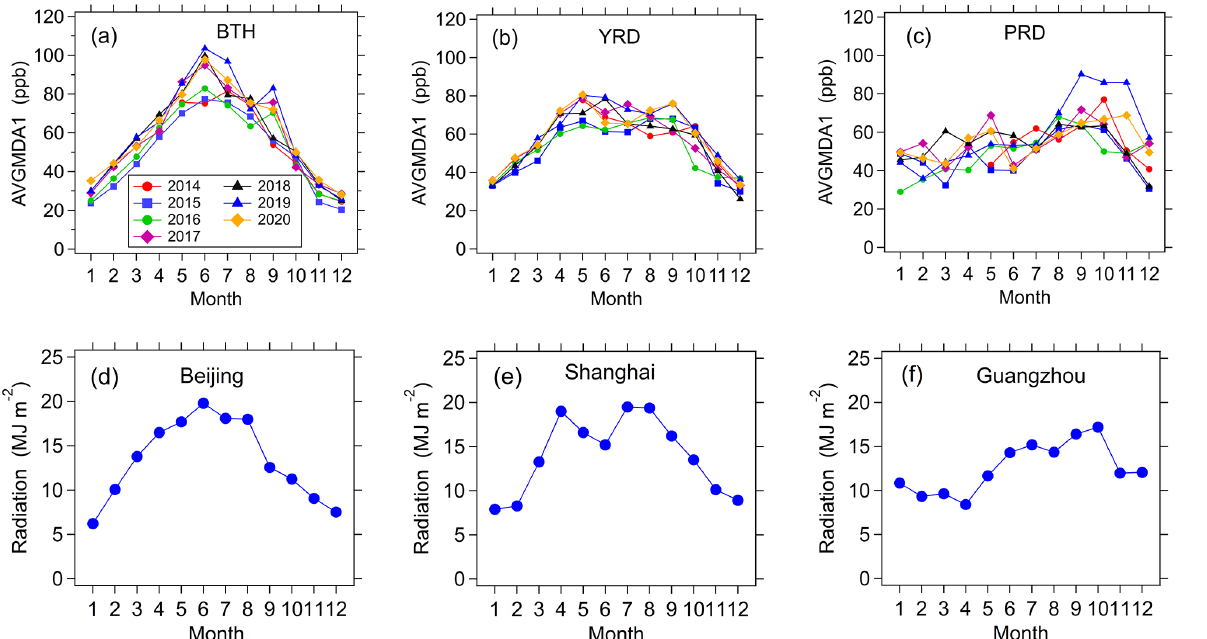
Figure 3. Seasonal variations in monthly mean MDA1 O 3 concentrations over all sites in BTH (a) , YRD (b) and PRD (c) during 2014– 2020. Seasonal variations in monthly mean solar radiation in representative cities of the three city clusters: Beijing in BTH (d) , Shanghai in YRD (e) and Guangzhou in PRD (f) in